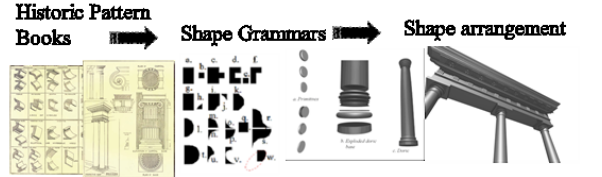
Figure 11: Parametric Library Objects built from Pattern